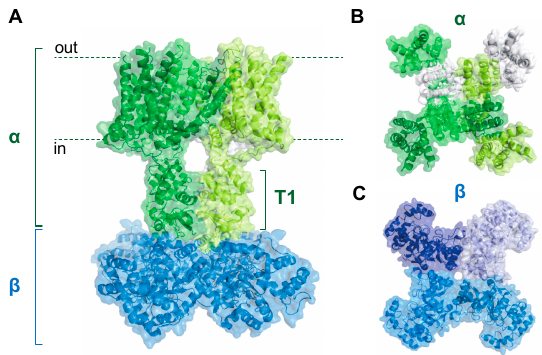
Figure 1. Kv1 α 4 β 4 complex structure. ( A ) Sideview of the Kv1 holochannel structure showing interaction between the pore-forming α tetramer (green) and the intracellular Kv β tetramer (blue). The intracellular T1 domain of the α subunits serves as a docking platform for the Kv β subunits. ( B , C ) Top-down ( B ) and bottom-up ( C ) views of the structure shown in ( A ). Distinct peptides are shown with differential shading. Adapted with the Pymol software using protein database ID